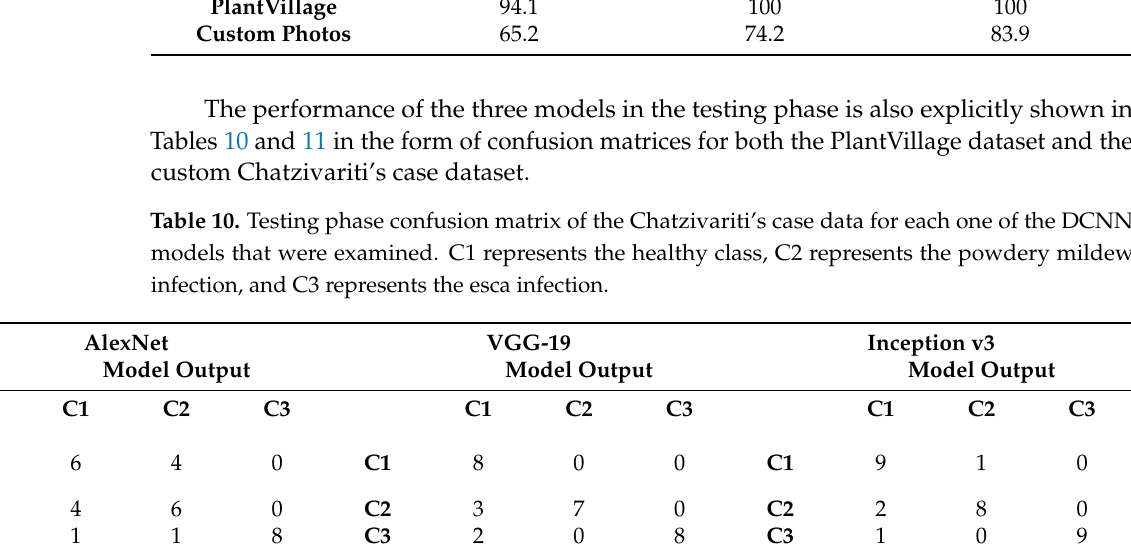
Table 9. Testing results of AlexNet, VGG-19, and Inception v3, with the PlantVillage and the custom